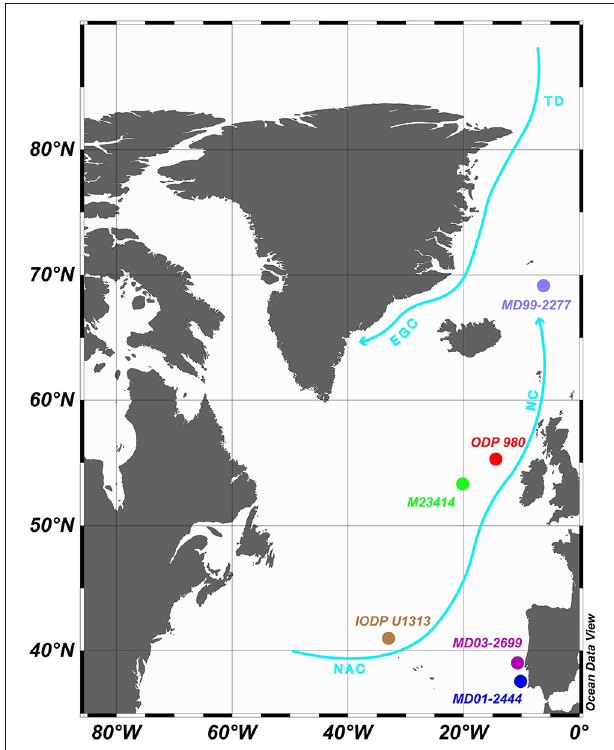
FIGURE 2 | Selected records and relevant currents. North Atlantic Current (NAC), Norwegian Current (NC), East Greenland Current (EGC) and Transpolar Drift Stream (TD) are depicted. This figure was generated using Ocean Data View (Schlitzer,